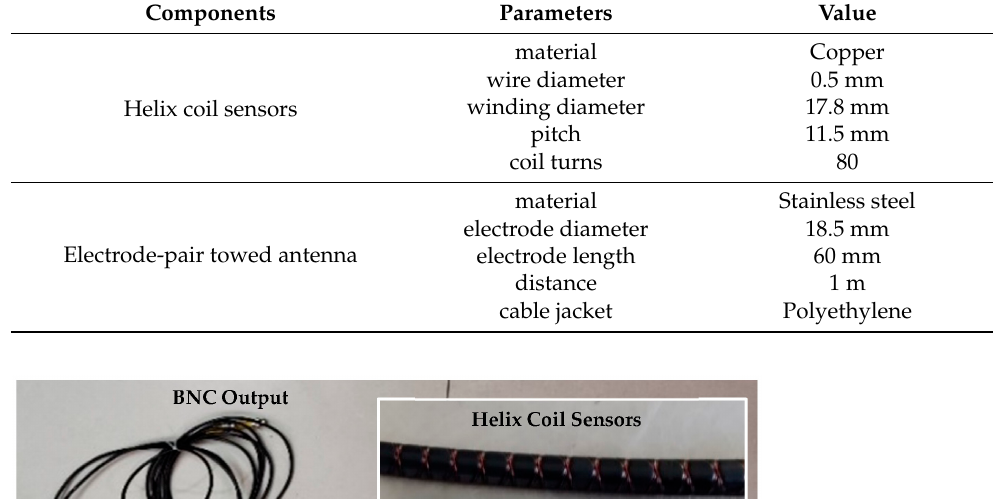
Table 1. Experiment platform parameters.